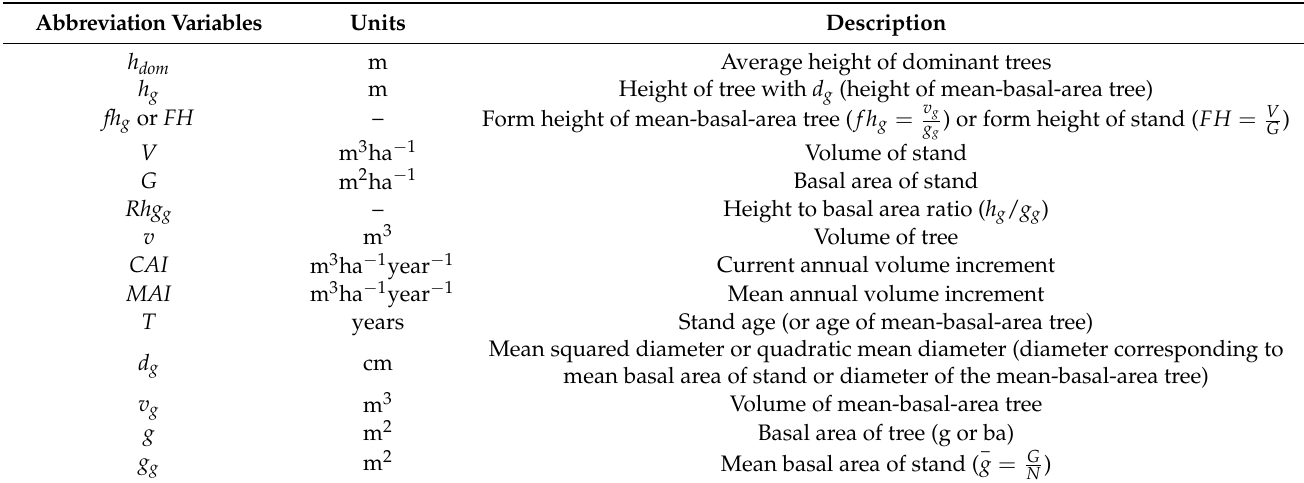
Table 1. Abbreviations for the used tree variables, their units, and a short description.